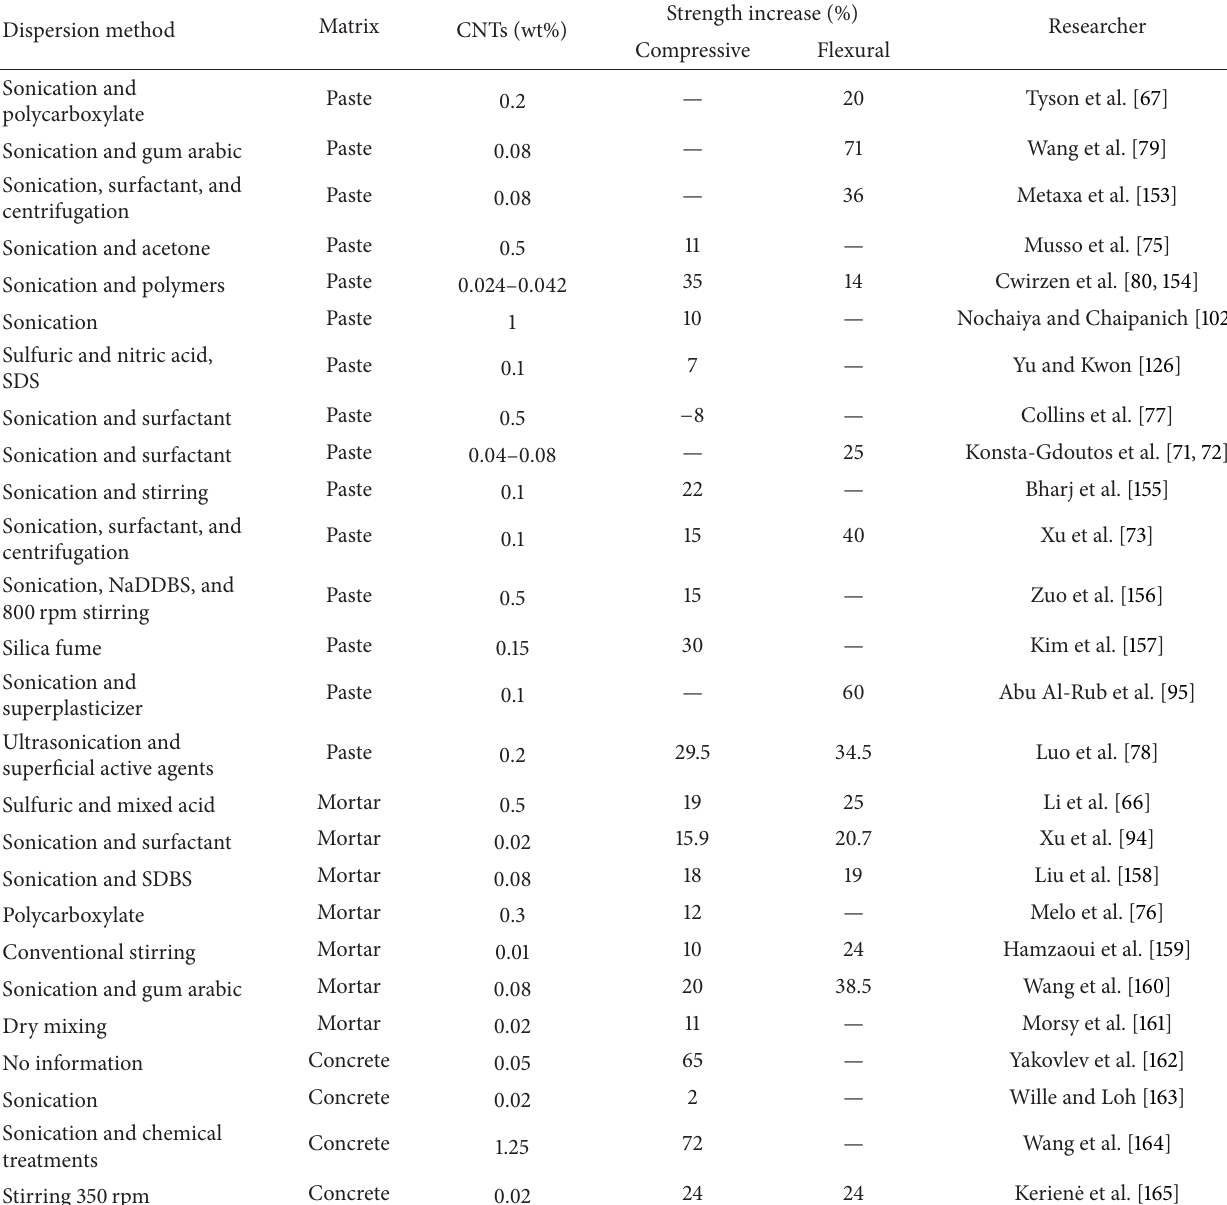
Table 2: Enhancement of CNTs to strength of cementitious